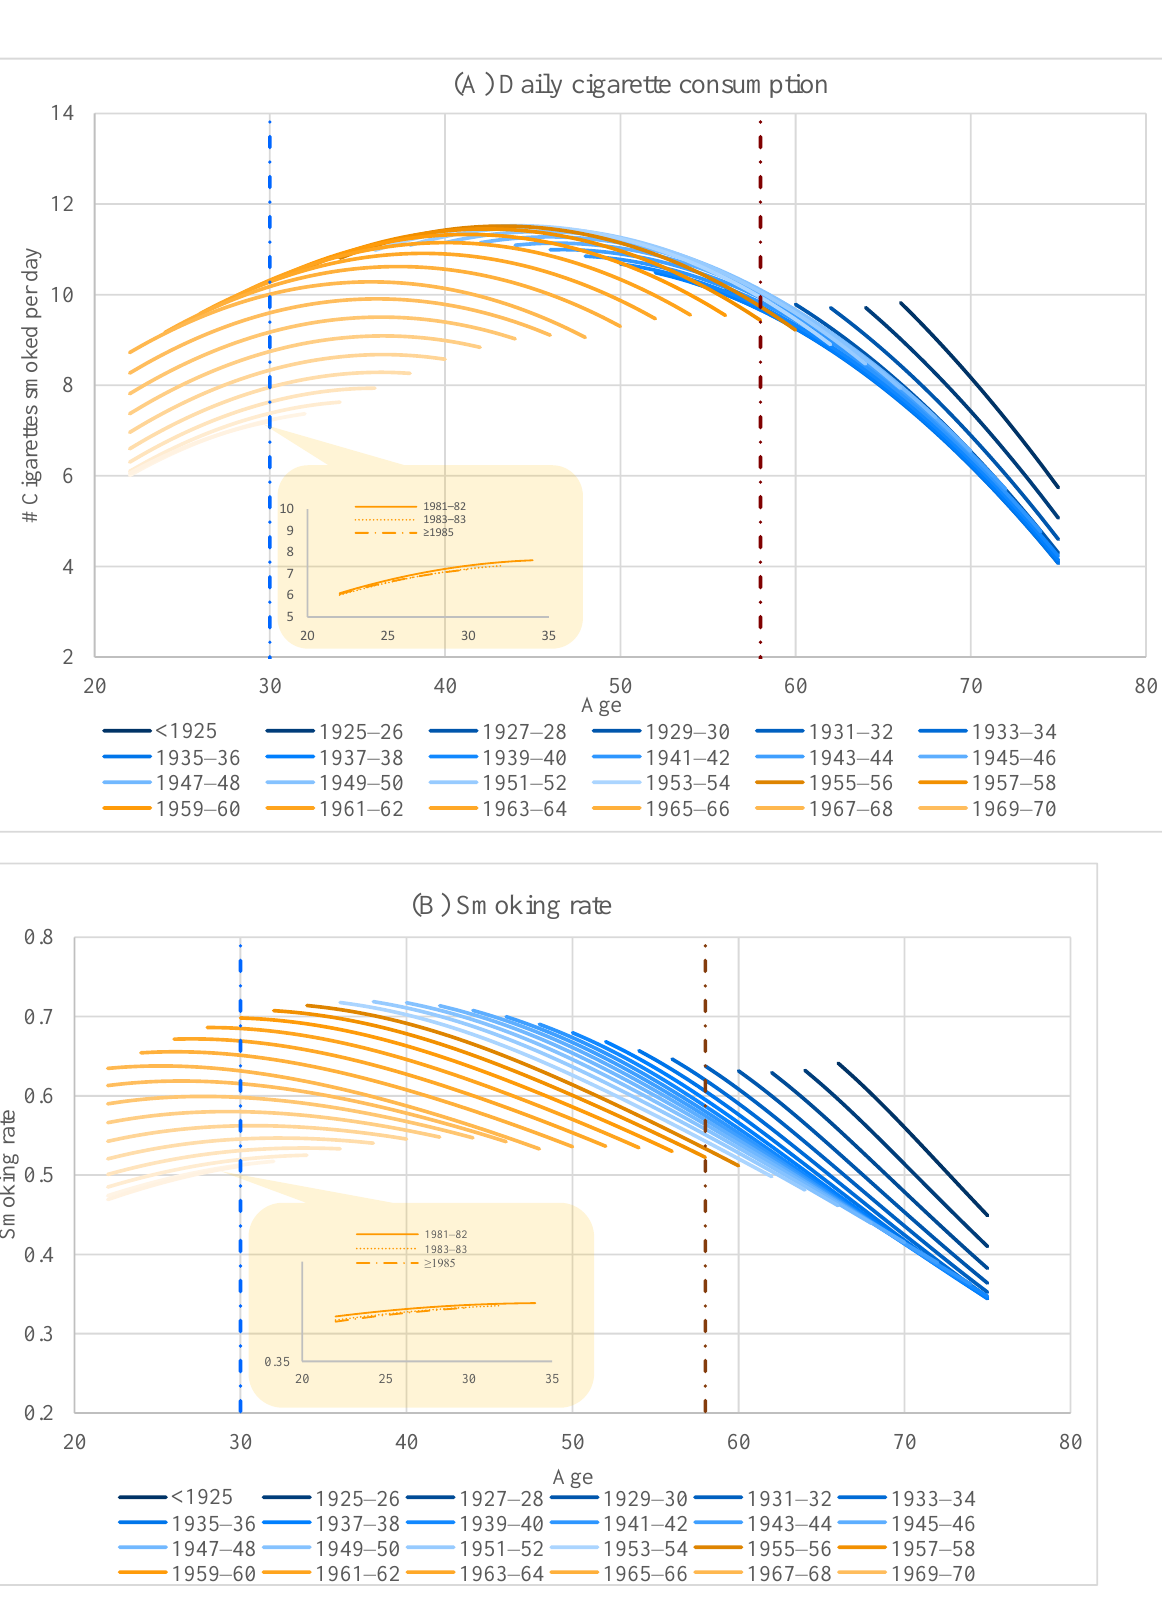
Figure 1. Life-course trajectories of smoking behavior by cohorts. Note 1: The predication is based on Models 1 and 4 in Table 2. Note 2: Vertical lines are placed at two age points, 30 and 58, to facilitate discerning changes in smoking across cohorts. The age points were chosen to maximize the cohorts they intersect with.